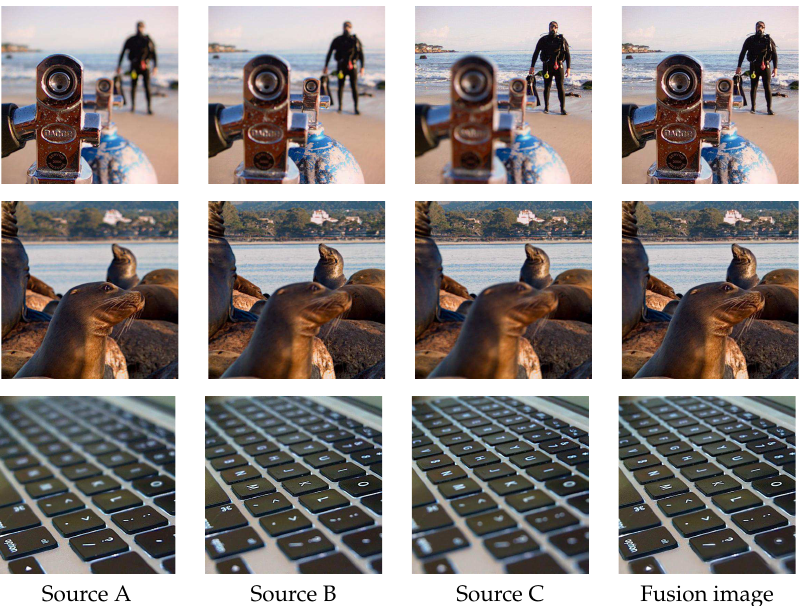
Figure 13. Fusion results of triple source images. Source A, Source B and Source C are images focused on three different distances: near, middle and far. Fusion image is the final fusion result.